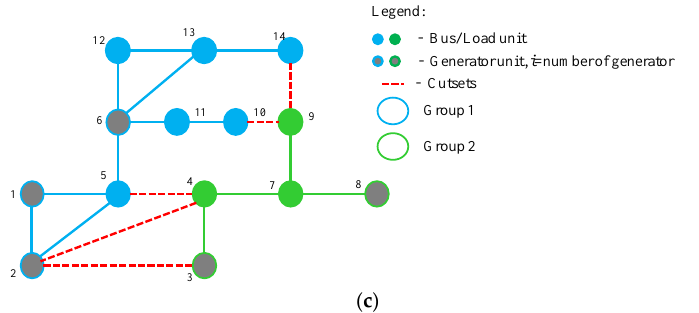
Figure 5. Initial cutsets determination using a heuristic approach. ( a ) Backbone formation; ( b ) The first stage; ( c ) The second stage.